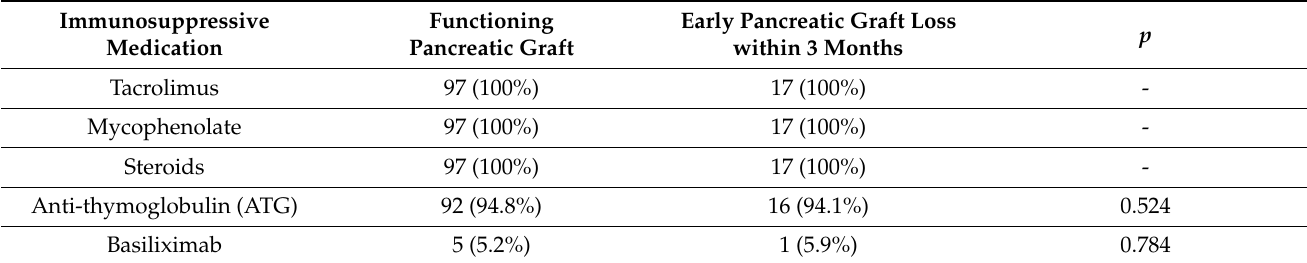
Table 2. Primary immunosuppression after